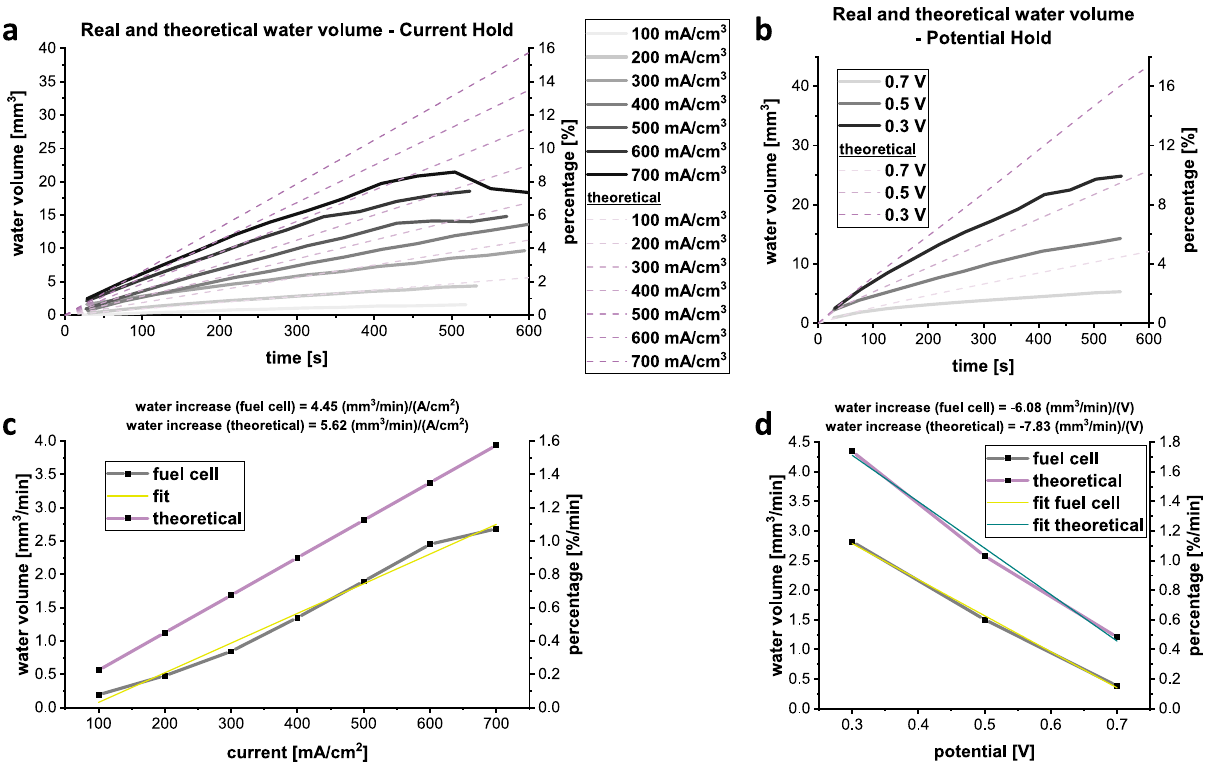
Fig. 5 Theoretical and observed water evolution inside the single serpentine fuel cell. a and b The theoretical and experimental water volumes for different current densities and potentials as dashed and solid lines, respectively, normalised to an active area of 1 cm 2 . c and d Compare theoretical and experimentally determined time-dependent water increases over the current and